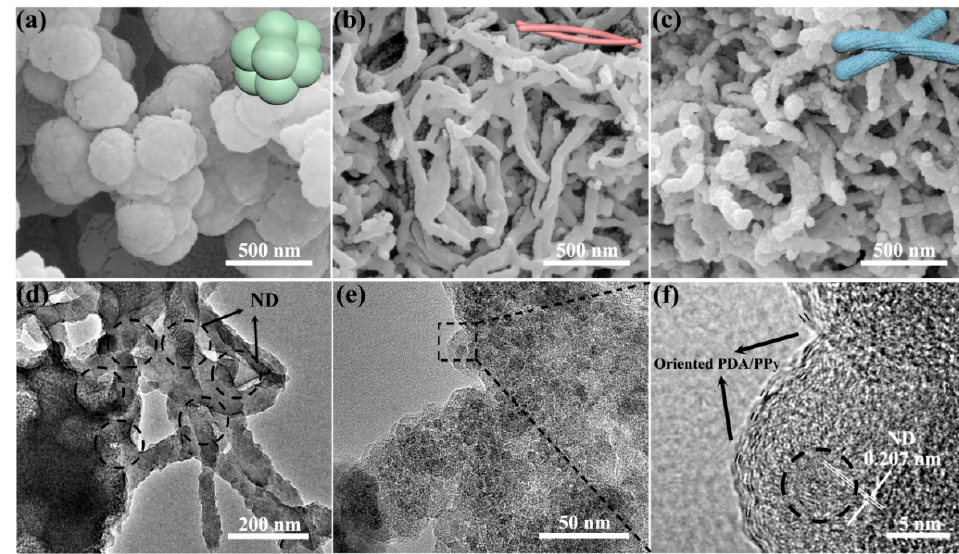
Figure 1. SEM images of ( a ) HCl-PPy, ( b ) PDA/PPy and ( c ) PDA/PPy/ND. The insert is the schematic for the related morphologies, ( d , e ) TEM images and ( f ) the HR-TEM image of PDA/PPy/ND. XRD patterns of PDA/Ppy/ND and the related samples are compared in Figure 2.